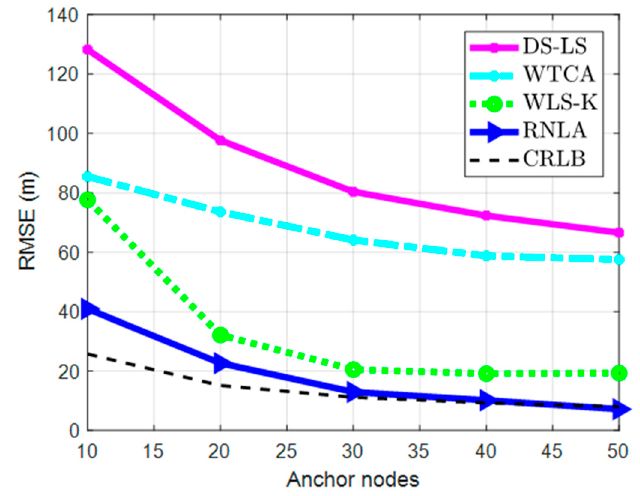
Figure 3. Root mean square error (RMSE) under variable anchor nodes. CRLB = Cramer–Rao low bound. Directly Squaring Least Square = DS-LS. Weighted Triangle Centroid Algorithm = WTCA. Weighted Least Square-Known parameters = WLS-K.